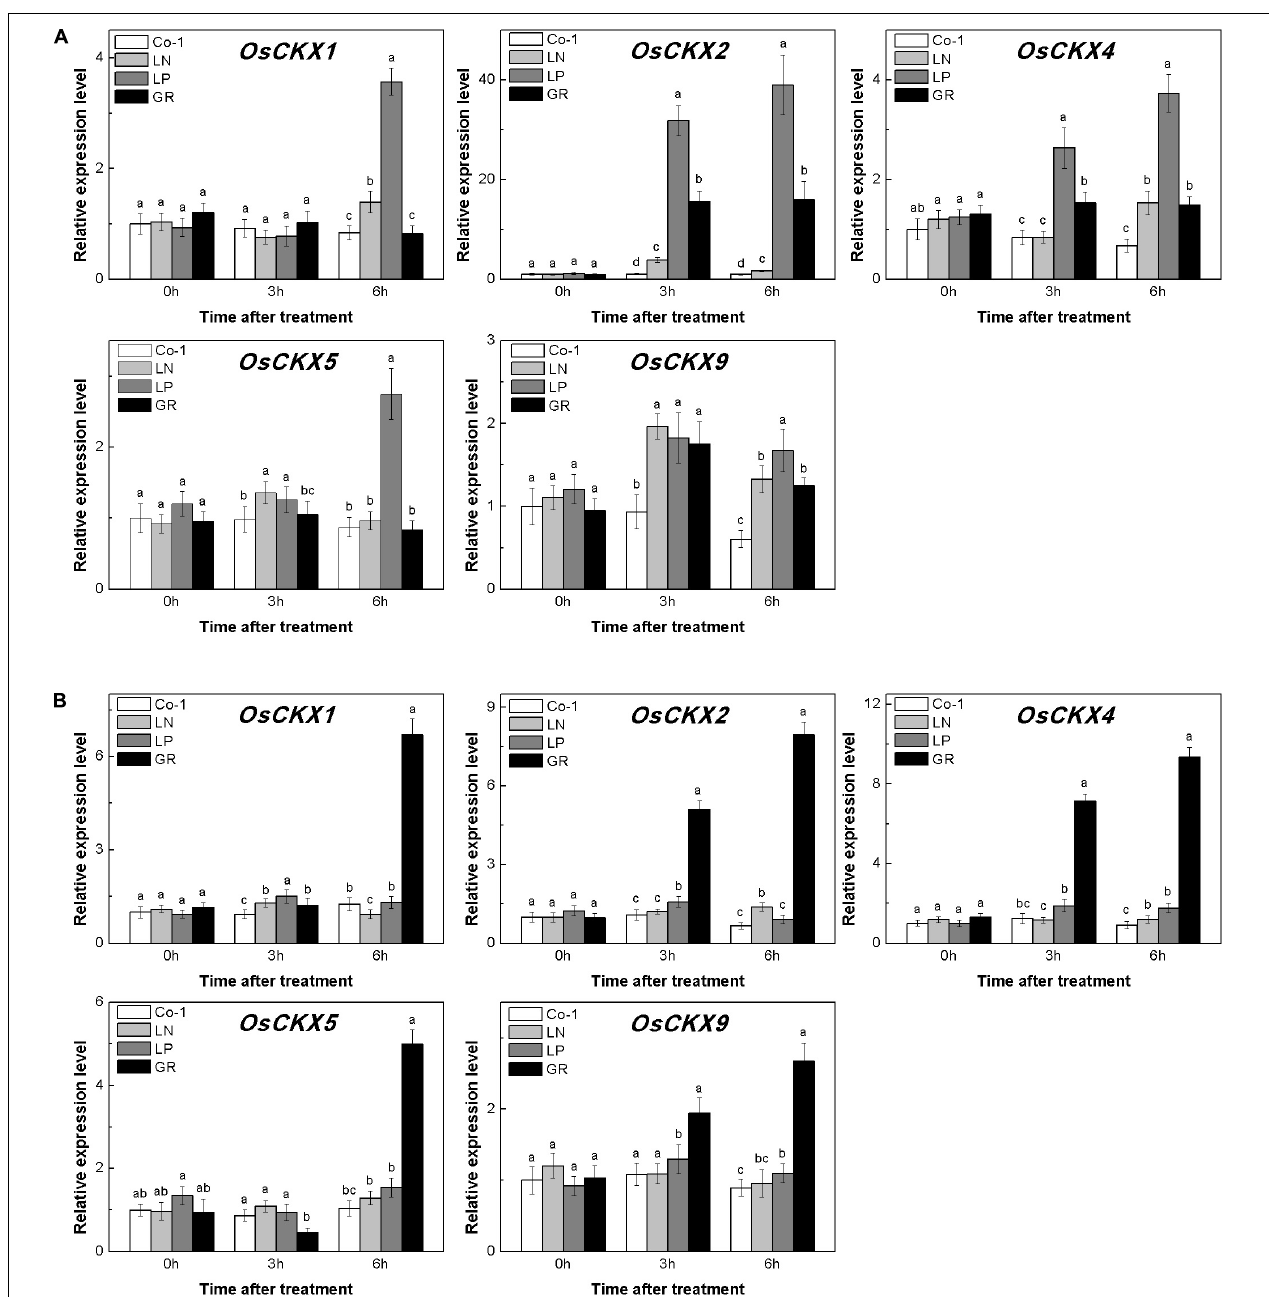
FIGURE 5 | Expression patterns of OsCKX1 , OsCKX2 , OsCKX4 , OsCKX5, and OsCKX9 CK degradation genes in rice tiller buds (A) and tiller nodes (B) located at the fifth leaf axils expressed in response to the treatment. Total RNA was isolated from less than 0.1 g of buds and nodes each time. β -Actin was used as a reference gene. The value obtained from the control treatment at 0 h after treatment was arbitrarily set at 1.0. Quantitative real-time PCR was performed in triplicate (three biological replicates), and mean values with SD are